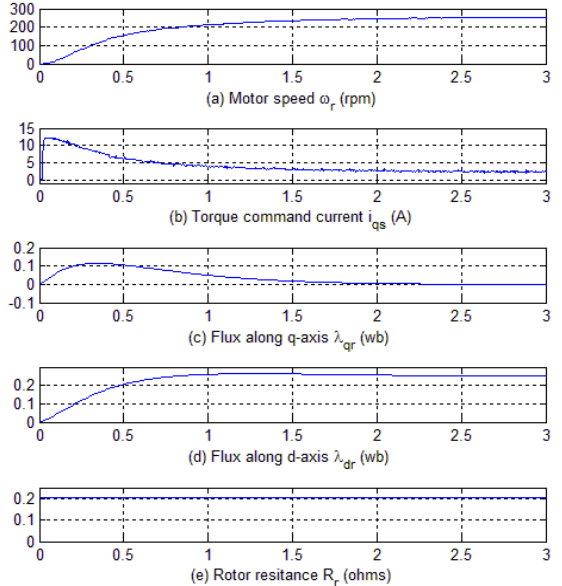
Figure 16. Experimental results with R r /2 and no adaptation. ( a ) Motor speed in rpm; ( b ) Torque command current in synchronous frame of reference; ( c ) Flux along q-axis in synchronous frame of reference; ( d ) Flux along d-axis in synchronous frame of reference; ( e ) Rotor